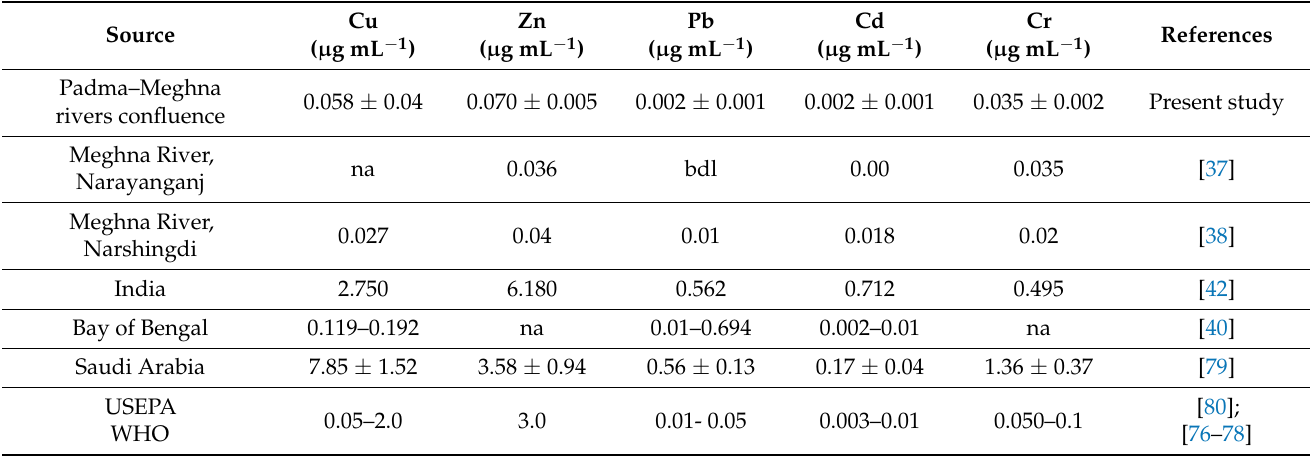
Table 3. Relative study of HMs concentration ( µ g mL − 1 ) obtained from the surface water at the confluence of the Padma and Meghna rivers (present study), guidelines, and relevant literature. na = not analyzed, bdl = below detection limit.